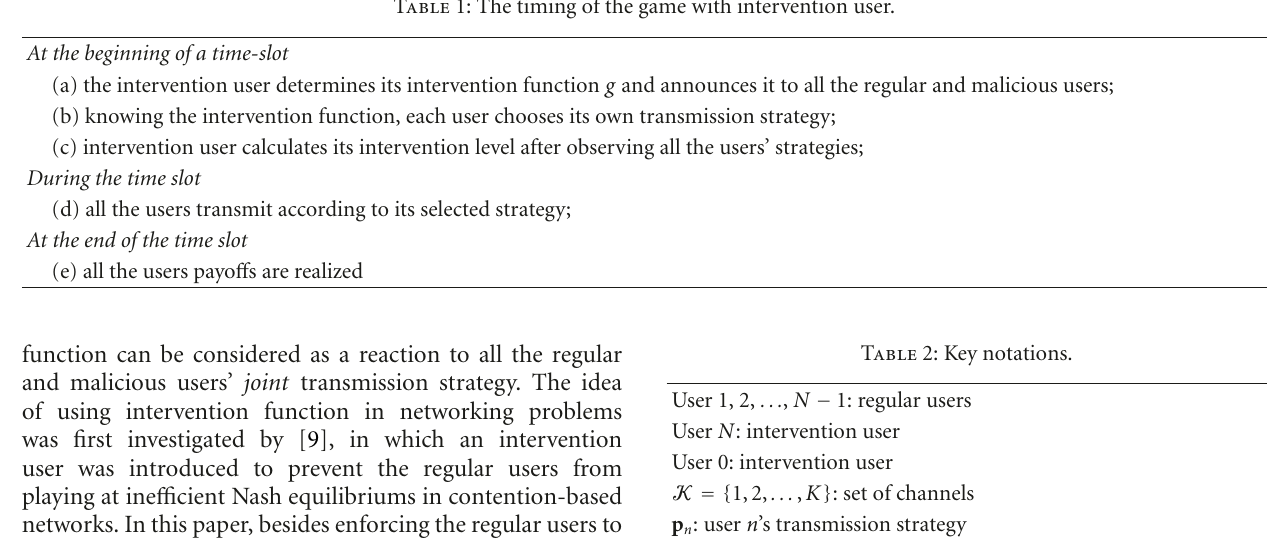
Table 1: The timing of the game with intervention user.